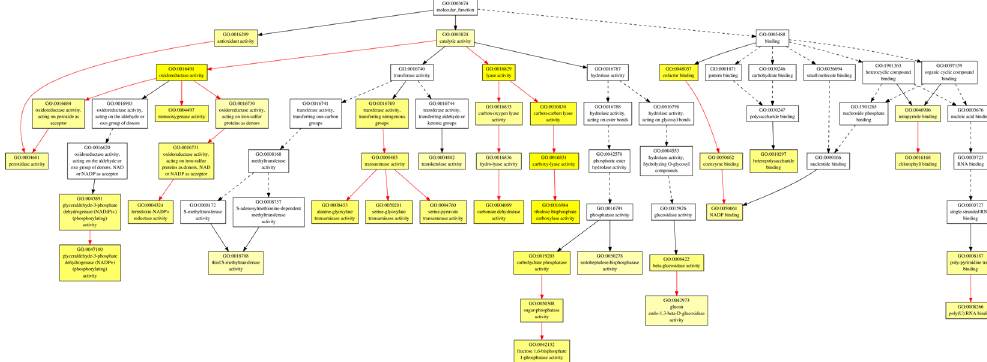
Figure 6. Molecular Function (MF) of GO term enrichment for down-regulated common DEGs in A. stolonifera . Yellow color indicates significantly enriched GO terms. The density of color in each node was proportional to statistical significance of enrichment of the corresponding GO term. Red edges stand for relationship between enriched GO terms.